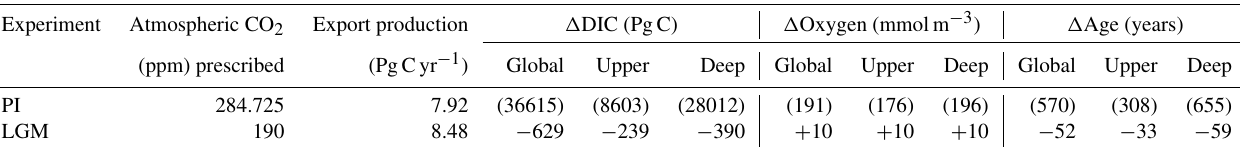
Table 2. Changes in dissolved inorganic carbon, dissolved oxygen, and water-mass age from PI referred to the global ocean inventory or global ocean mean values. Values in brackets are the PI results. Upper (deep) ocean is above (below) 1000m depth. Atmospheric CO 2 concentration is prescribed in each